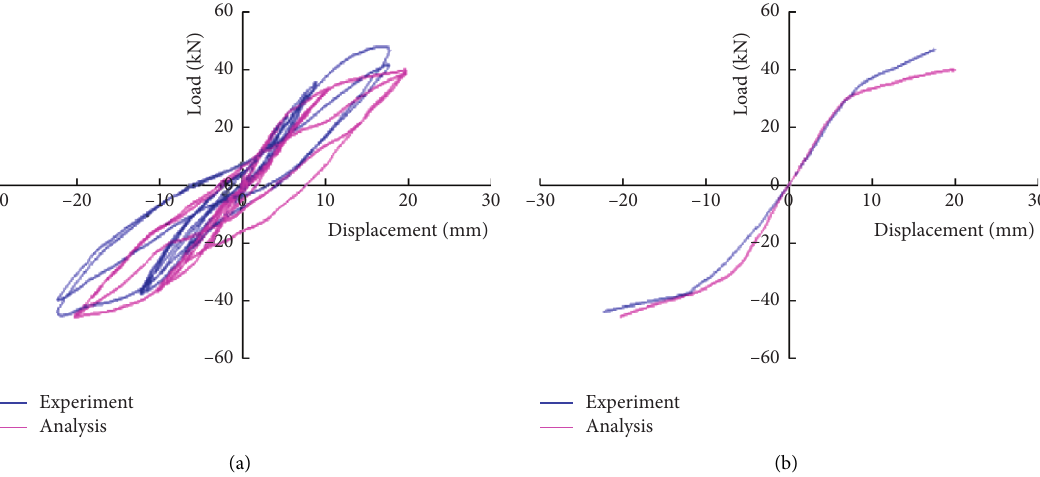
Figure 8: Comparison of the hysteretic curves and skeleton curve of model 1 (before): (a) hysteretic reinforcement; (b) skeleton